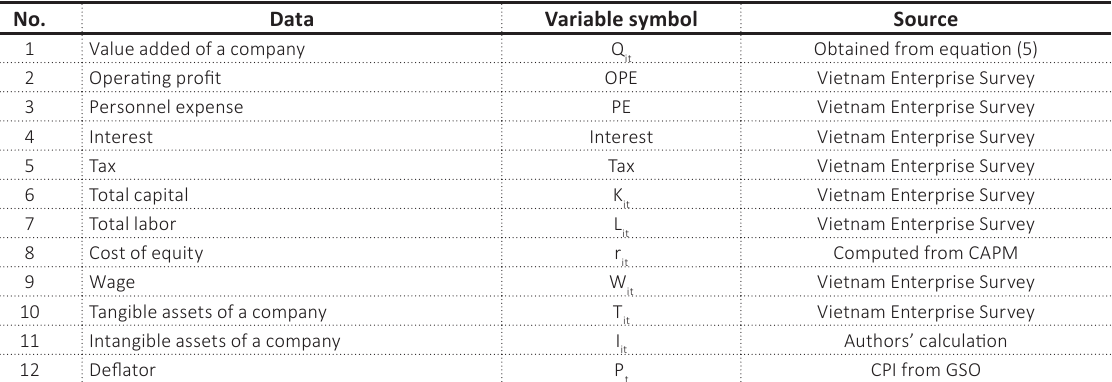
Table 1. Description of variables used in the model